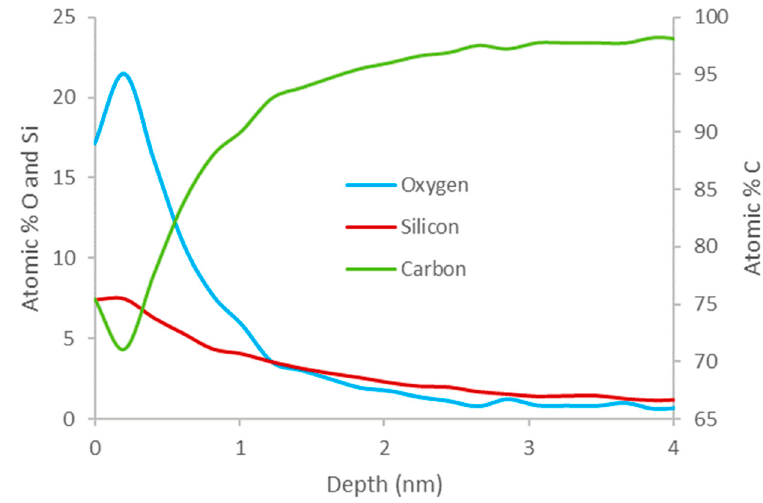
Figure 4. Depth profile of propyltrimethoxysilane (PTMS) 3. 220